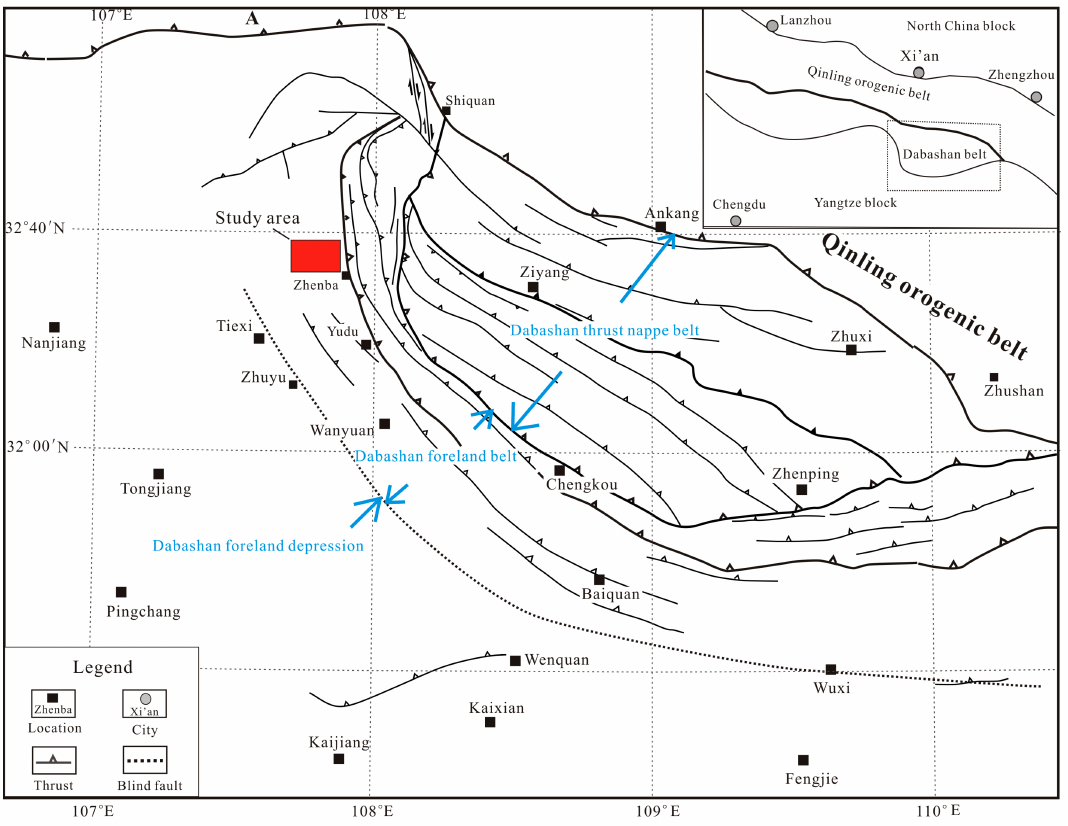
Figure 1. Tectonic setting map of the Dabashan belt in the northwestern Upper Yangtze Plate (modified from